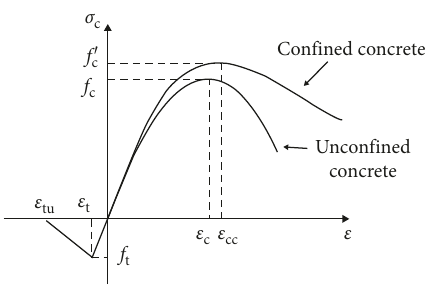
Figure 13: Stress-strain of